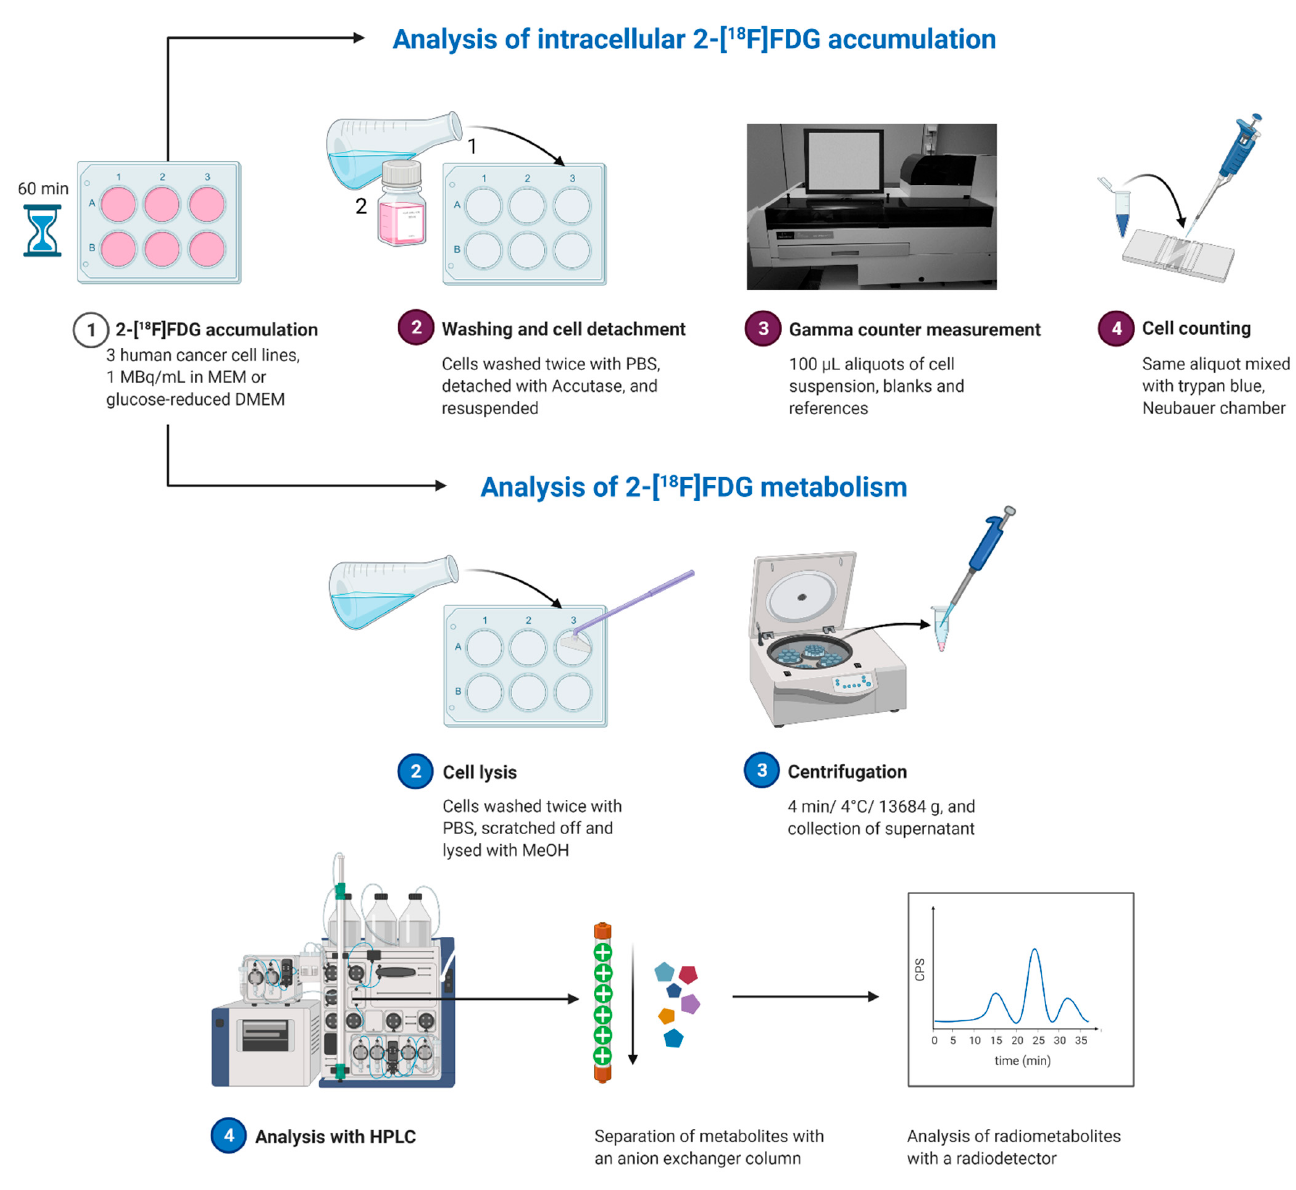
Figure 2. Workflow of experiments determining intracellular 2-[ 18 F]FDG accumulation and metabolism. Adapted from “Protein Purification by Size-Exclusion Chromatography” by BioRender.com (accessed on 4 September 2021). Retrieved from https://app.biorender.com/biorender ‐ templates.